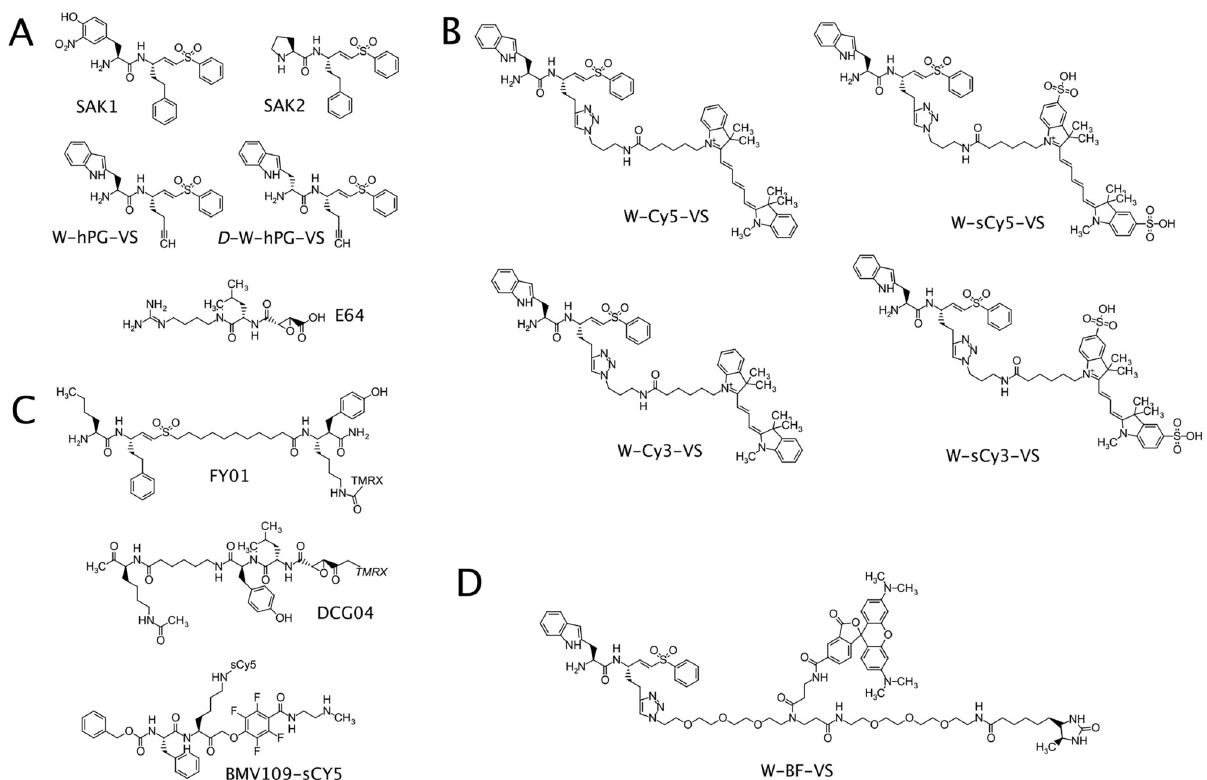
Fig 1. Structures of inhibitors and ABPs. ( A ) Structures of inhibitors used in this study. All the new ABPs described in this paper were synthesized by conjugating different azido-tags ( B , fluorophore or D , a biotin/TAMRA bifunctional tag) to the alkyne group of W-hPG-VS. ( C ) Structures of previously published ABPs used in this study for comparison